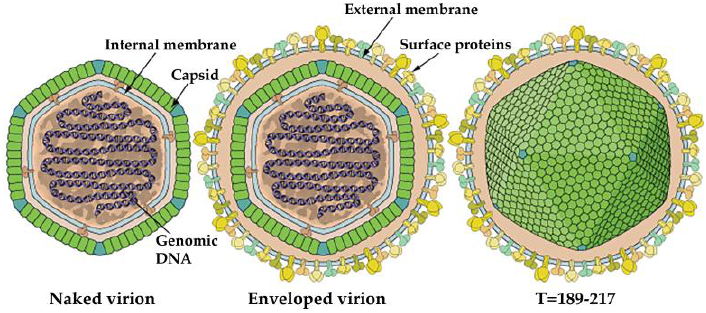
Figure 3. Graphical representation of the iridovirid structure [73]. Source: ViralZone: www.expasy.org/viralzone, SIB Swiss Institute of Bioinformatics.